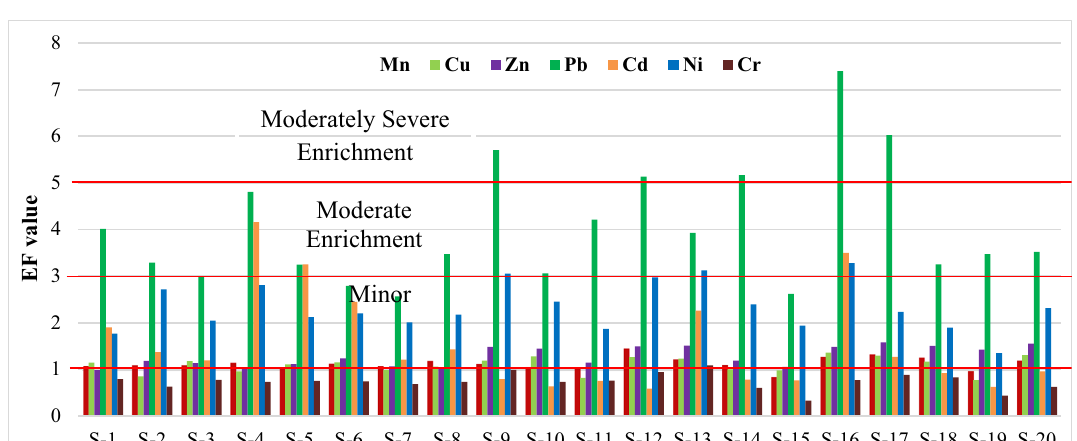
Figure 5. Trace metals geo-accumulation (I-geo) in the Sundarbans soils.